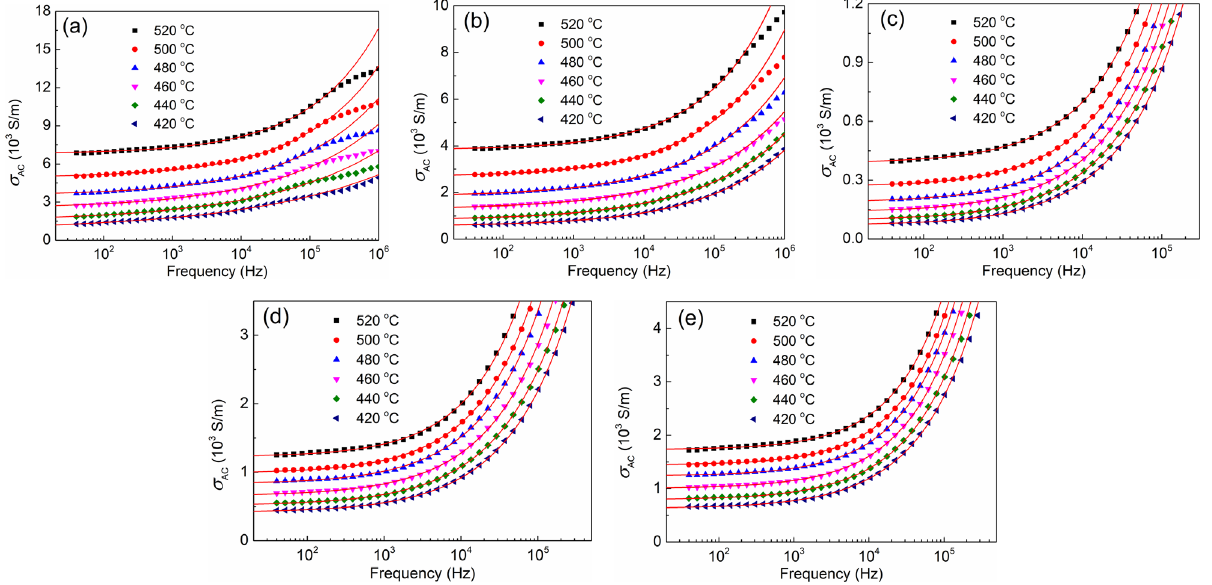
Fig. 10 Frequency dependent σ AC of (1 − x )KNN– x BZN ceramics at selected temperatures: (a) x = 0.010, (b) x = 0.015, (c) x = 0.020, (d) x = 0.025, and (e) x = 0.030. The red lines show nonlinear fitting based on Eq.